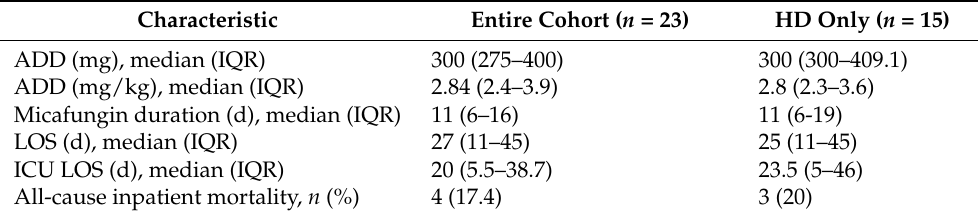
Table 3. Micafungin Treatment data and clinical outcomes among the entire study cohort and